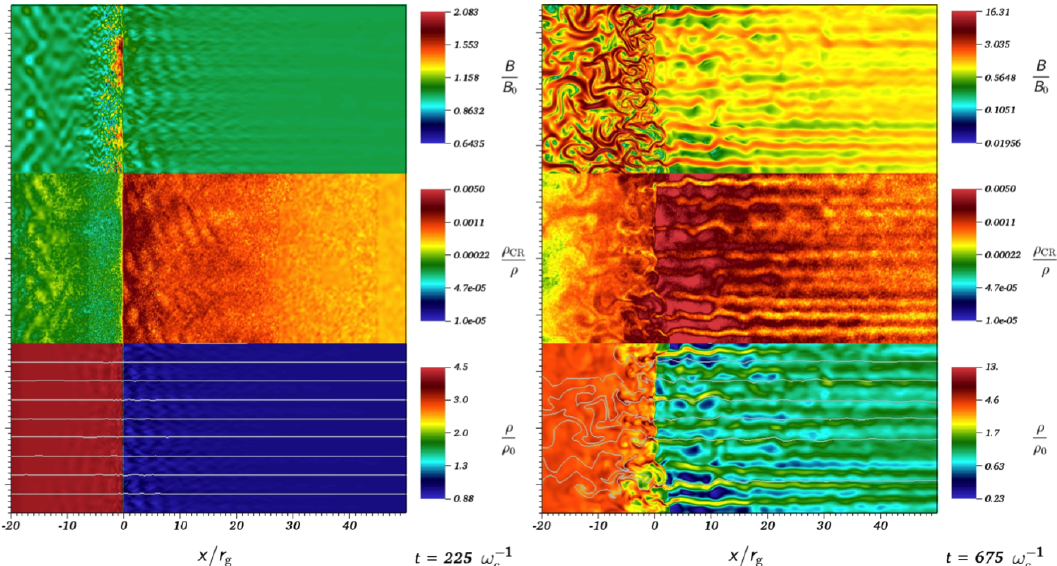
Figure 6. Color maps of the magnetic field amplitude ( top panels ), NTP density (middle panels) and plasma density with the magnetic field stream lines ( bottom panels ) in the early stages of a parallel shock simulation by [183] with a hybrid PIC-MHD code. The gas is streaming through the shock from right to left. Left panels ( t = 225 ω − 1 c ; ω c is the ion gyrofrequency): the upstream medium shows the start of the streaming instability, while the downstream medium shows the onset of turbulence. Right panels ( t = 675 ω − 1 c ): Both the upstream streaming instability and the downstream turbulence are now fully developed. The shock is warping in response to the instabilities. (Figure adapted from Figures 2 and 4 of